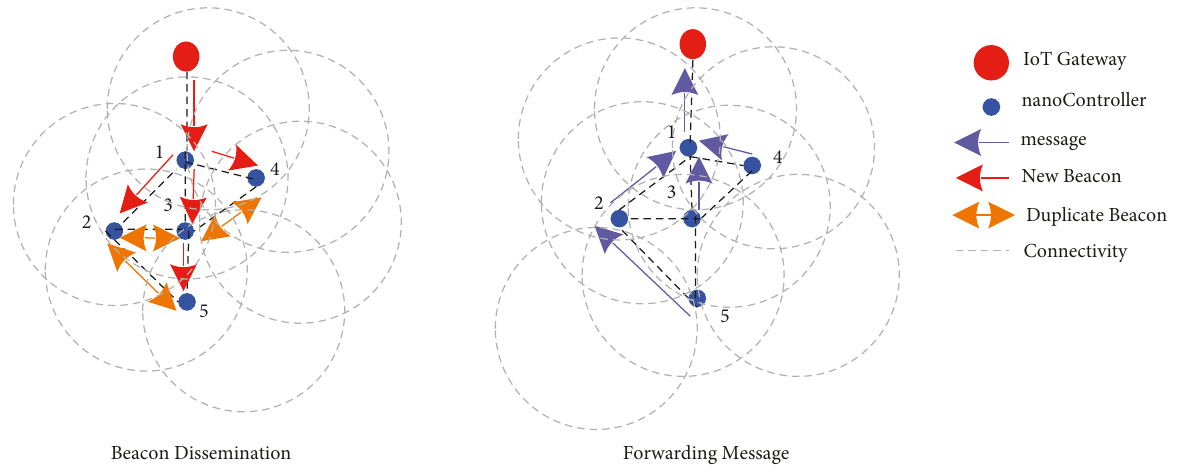
Figure 6: Data dissemination of TEForward.